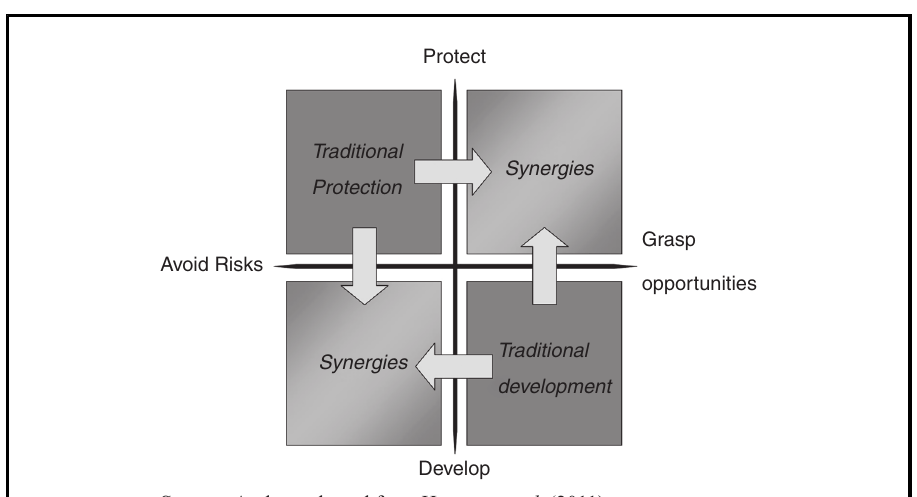
Figure 1 Finding synergies between tourism and landscape